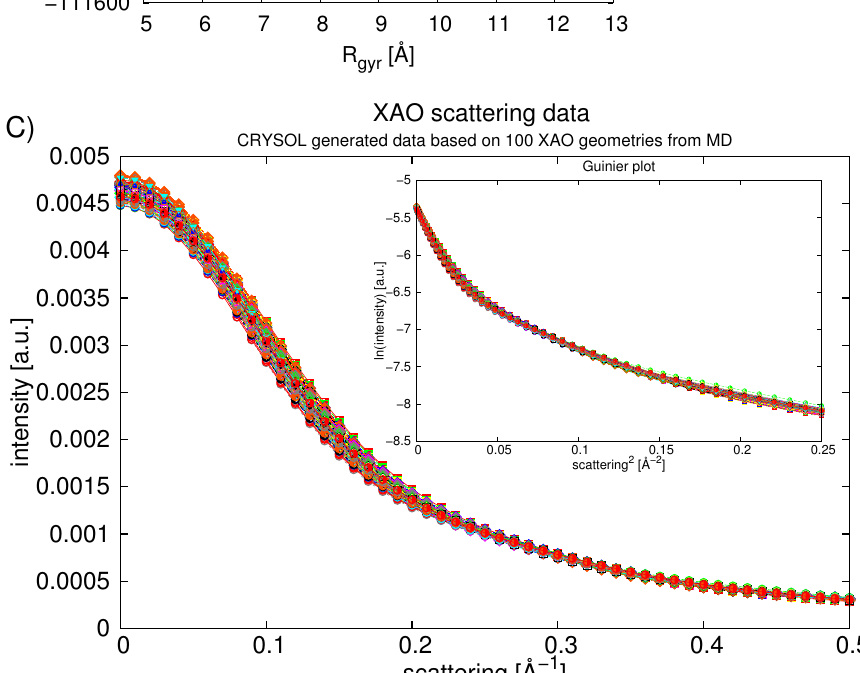
Figure 6. ( A ) the R gyr [Å] of XAO calculated over the 900 ns of classical MD; ( B ) the calculated QM/MM energy [kcal/mol] of the XAO peptide is correlated with the R gyr [Å]; ( C ) intensity (arbitrary units) versus scattering (Å − 1 ) is plotted for 100 randomly chosen structures from MD simulations of XAO. Inset shows the Guinier plot of ln(intensity) vs. scattering 2